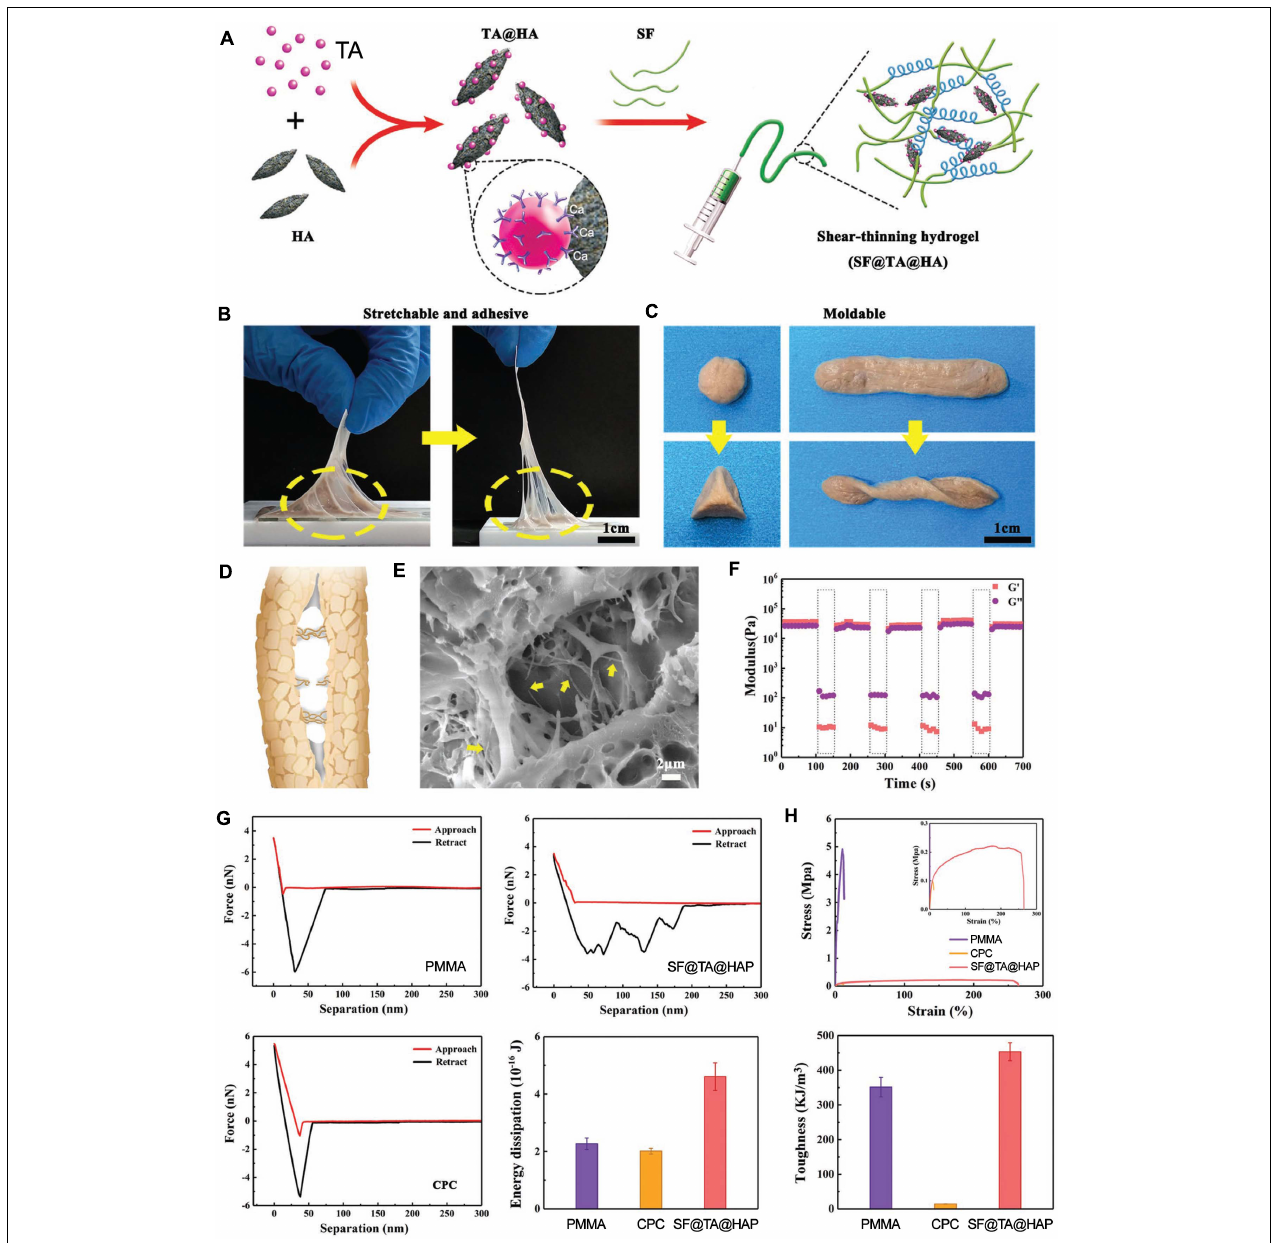
FIGURE 8 | Application of adhesive tissue engineering scaffolds (ATESs) in bone tissue engineering. (A) Demonstration of SF@TA@HAP hydrogel formation. (B) Demonstration of adhesion and stretchability of SF@TA@HAP scaffold. (C) Demonstration of the flexibility and malleability of the hydrogel. (D) Glue filaments in the bone structure, connecting mineralized collagen fibrils. (E) Representative SEM image of the filaments in the SF@TA@HAP hydrogel. (F) Modulus of SF@TA@HAP hydrogel under repeated application of 100 and 0.1% strain. (G) AFM mechanical testing of SF@TA@HA, PMMA, and CPC. Bar graphs show the quantified values of dissipated energy during the separation step. (H) Results of mechanical testing of SF@TA@HA, PMMA, and CPC samples. Bar graphs show the quantified toughness. Reconstructed with permission from Bai et al.